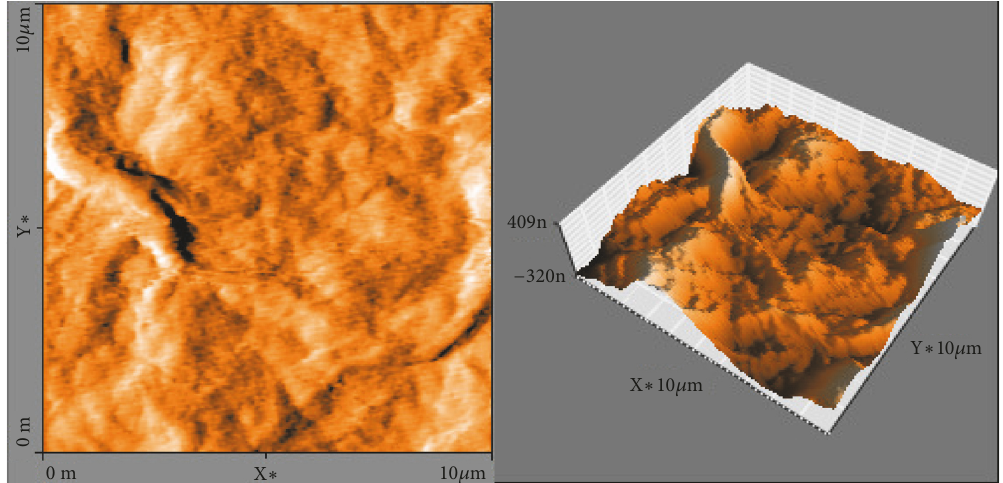
Figure5:AFMimageandthree-dimensionaltopographyof air-driedgrapheneoxidesolution takenusingtheDD-ACTAprobe.Thesample shows a region of elevated height with crater structure seen in the upper left hand corner of the three-dimensional topography